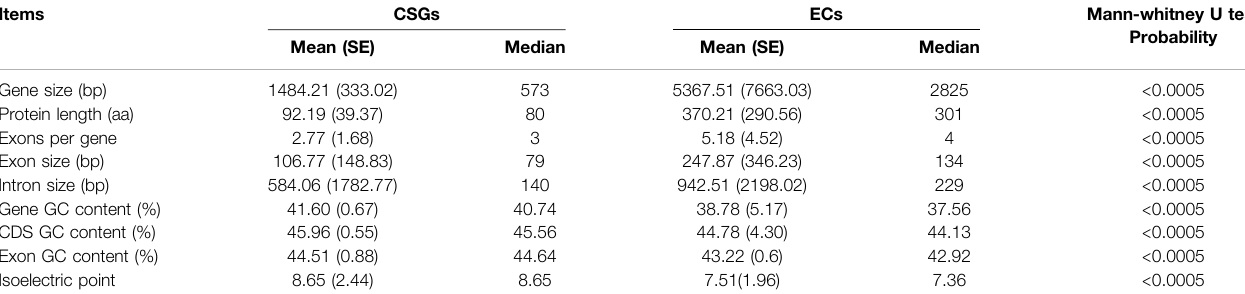
TABLE 1 | Genic features of camellia -speci fi c genes (CSGs) compared with evolutionarily conserved genes (ECs). Items